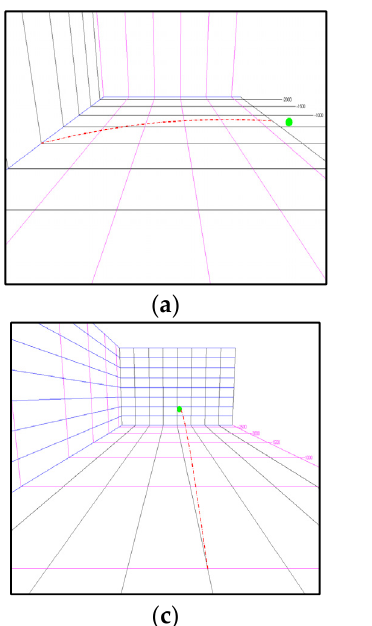
Figure 4. Real world experimental setup. ( a ) Ball throwing device. ( b ) Radar gun to measure launching speed. ( c ) Used camera (UI-1220RE-M-GL). ( d ) Trajectory captured through throw side camera.